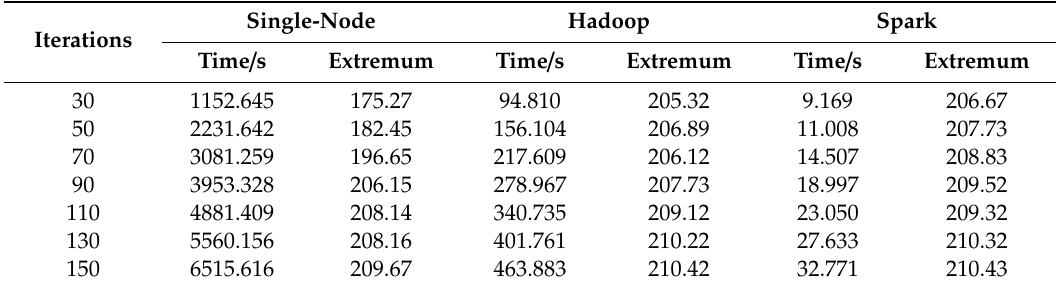
Table 2. The optimal result of GAESMPF based on single-node, Hadoop, and Spark.